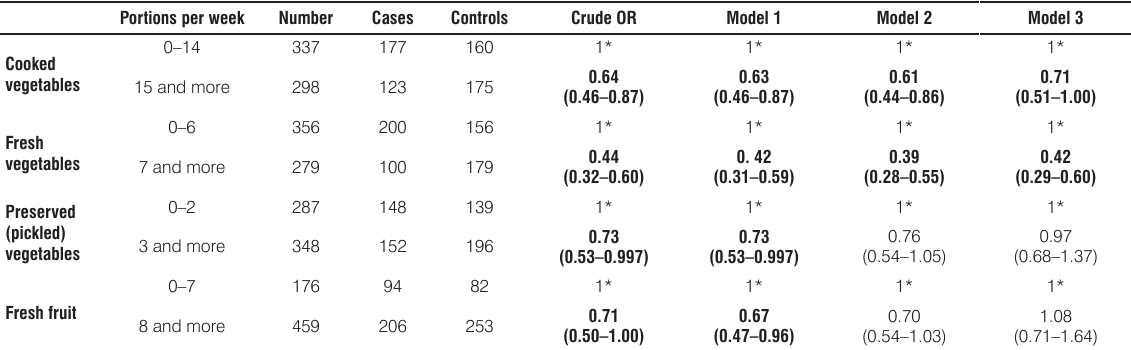
Table 2. Associations between weekly consumption and culinary preparation of vegetables and fruits and kidney cancer cases and controls.